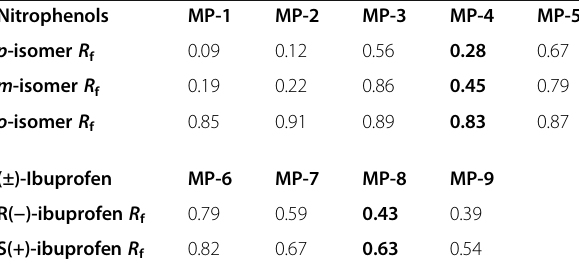
Table 1 Retardation factors of p-, m-, and o-nitrophenol, and R( − )-, S(+)-ibuprofen developed on SC-2P/Cu 2+ TLC plates using different mobile phase systems (MPs) Nitrophenols